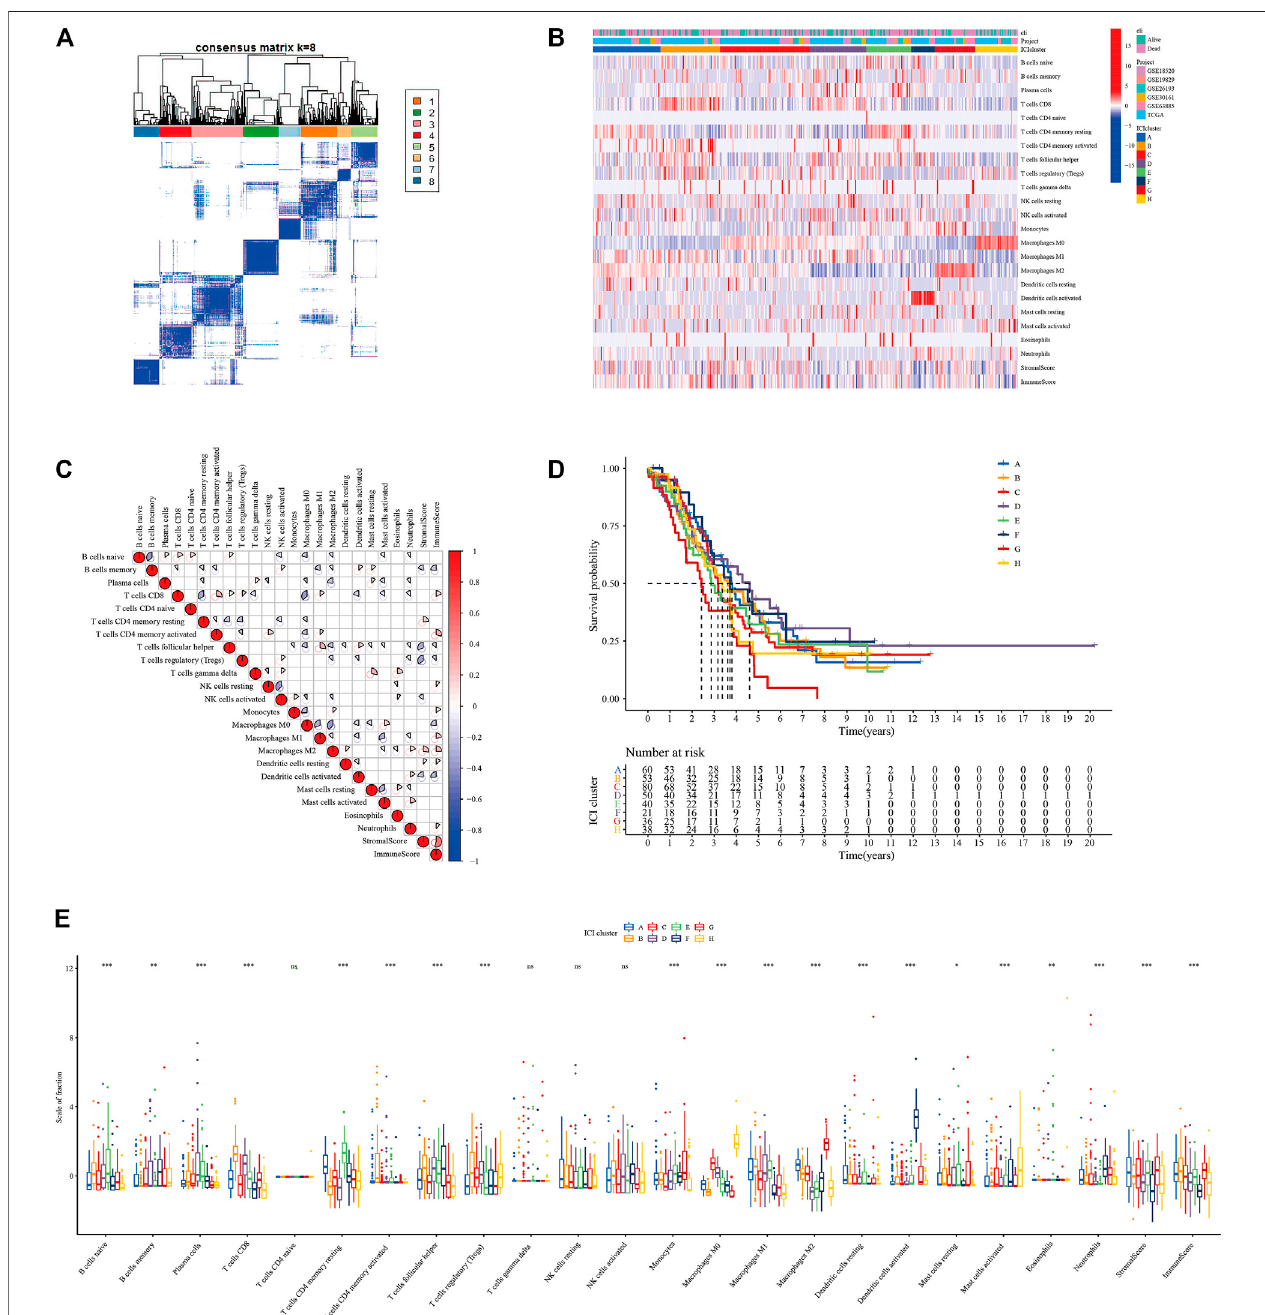
FIGURE 2 | In fi ltration of immune cells in TME of patients with OC (GSE18520, GSE26193, GSE19829, GSE30161, GSE63885, and TCGA-OV). (A) Consensus matrixes of all OC samples (k (cid:1) 8). (B) Unsupervised clustering heat maps of tumor-in fi ltrating immune cells. (C) Correlation analysis between 22 tumor-in fi ltrating immune cell types. (D) Kaplan-Meier overall survival curve of the 8 ICI subtypes. (E) Difference analysis of 22 tumor-in fi ltrating immune cell types in 8 ICI subtypes.